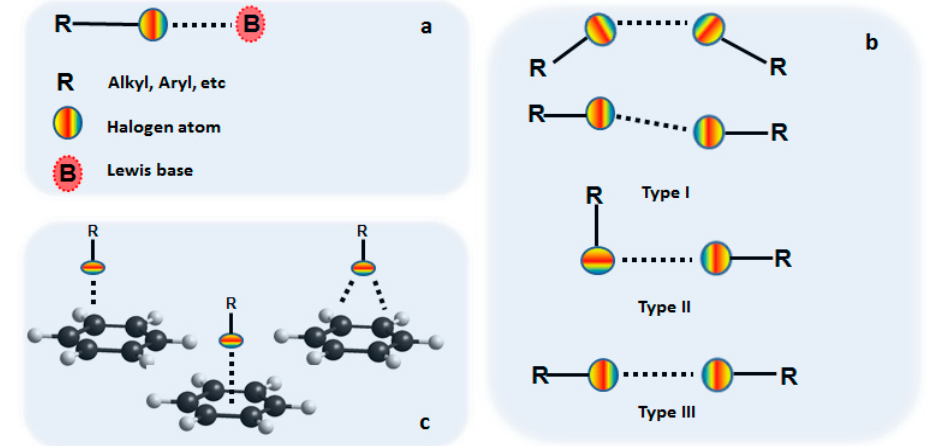
Figure 1. General description of a halogen bond and the types of halogen interactions (blue color depicts the σ -hole): ( a ) general description of the halogen bond; ( b ) halogen–halogen interactions; ( c ) halogen– π interactions (over-the-atom, over-the-bond and